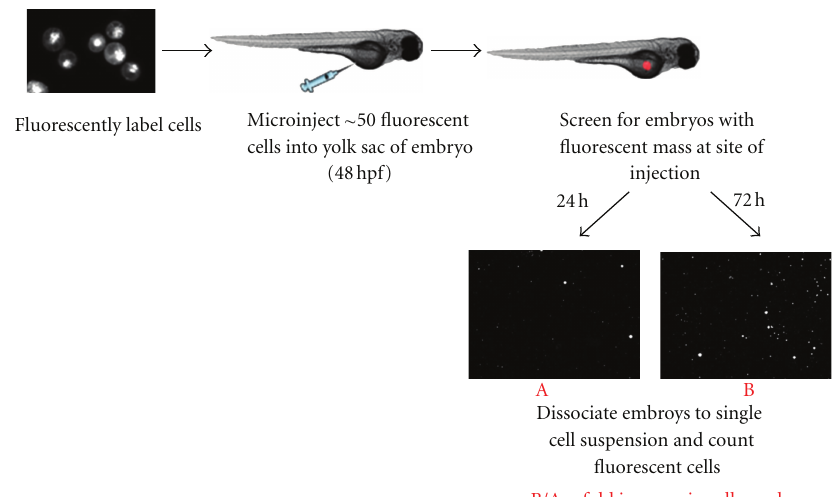
Figure 2: Schematic of in vivo cell proliferation assay in xenotransplanted zebrafish embryos. Human leukemia cells are fluorescently labelled with a cell tracking dye. Approximately 25–50 fluorescently labelled cells are microinjected into the yolk sac of 48hpf casper embryos. Embryos are screened using fluorescent microscopy for the presence of a fluorescent mass at the site of injection. Positive embryos are divided into two groups; one of which is maintained at 35C for 24 h, and the other group is maintained for until the time point of interest with or without drug exposure. At the end of each time point embryos are enzymatically dissociated to a single cell suspension and the number of fluorescent cells in the suspension is counted using a semiautomated macro in Image J (NIH, Bethesda, MD). The number of fluorescent cells present at the later time point divided by the number of fluorescent cells present at 24 h represents the fold increase in cell number. Adapted from Corkery et al.